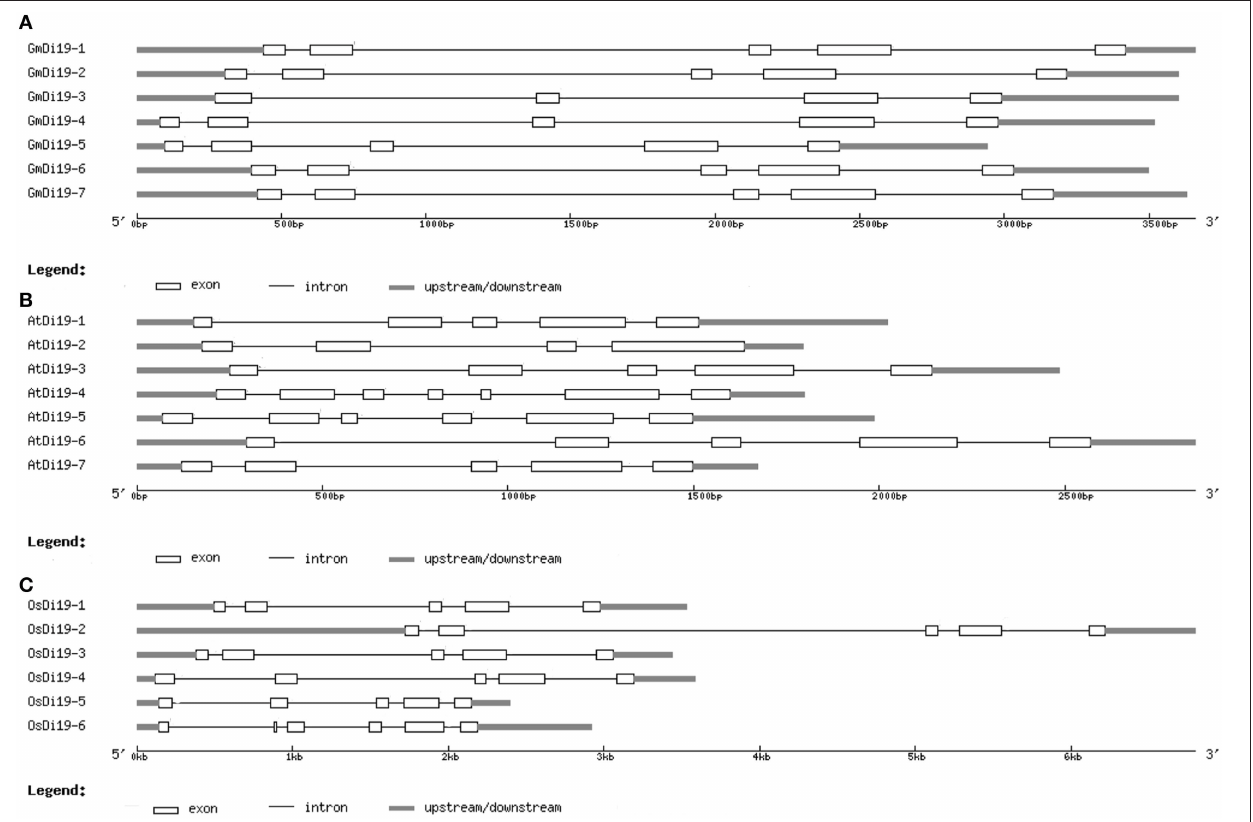
FIGURE 3 | Gene structures of soybean Di19s (A), AtDi19s (B), and OsDi19s (C). Exons and introns are represented by white boxes and blank lines,